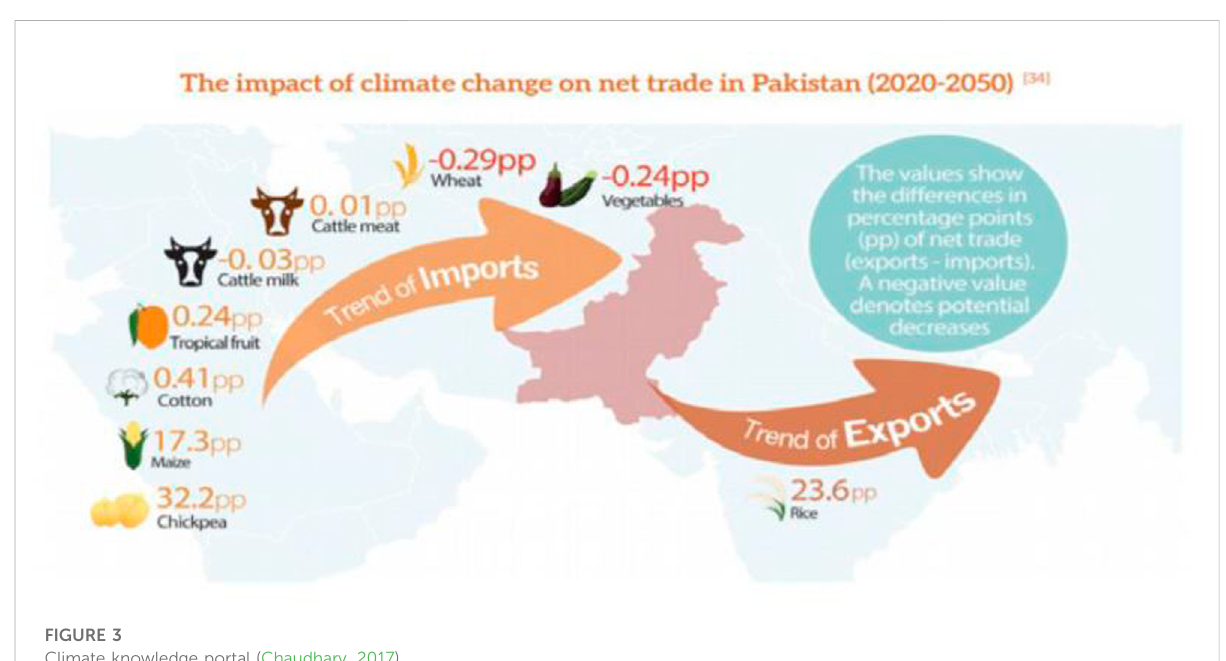
FIGURE 3 Climate knowledge portal (Chaudhary,